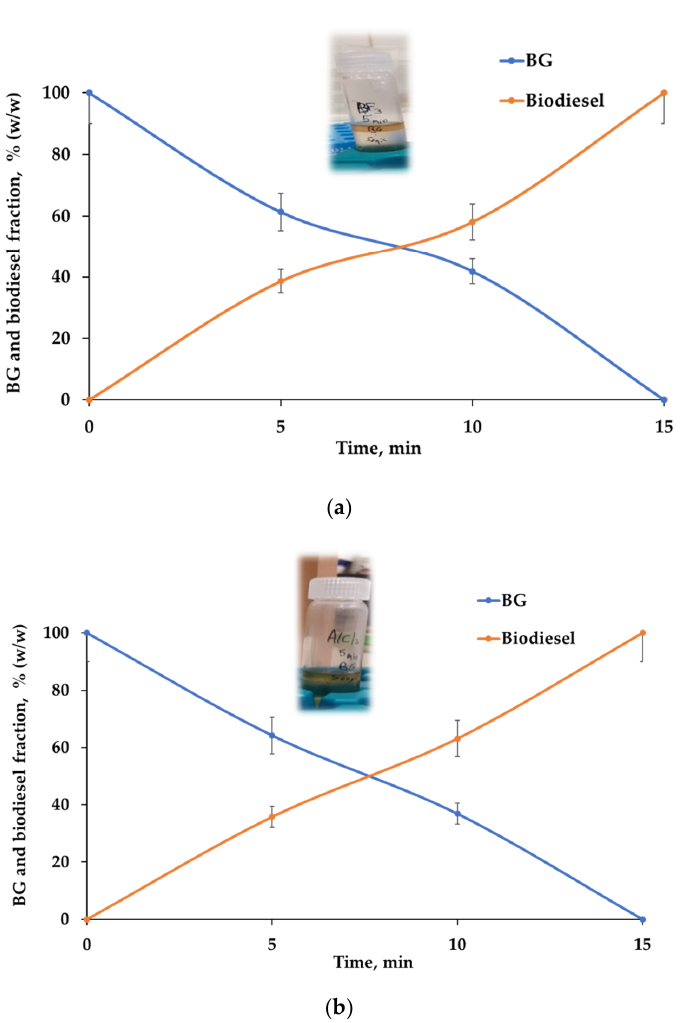
Figure 4. Efficiency of brown grease esterification by methanol catalyzed by ( a ) 5.33% BF 3 and ( b ) 43.9 mg/mL AlCl 3 under bath sonication at 37 kHz at the ambient temperature. BG—brown grease. In the insets—photo of samples after the reactions.